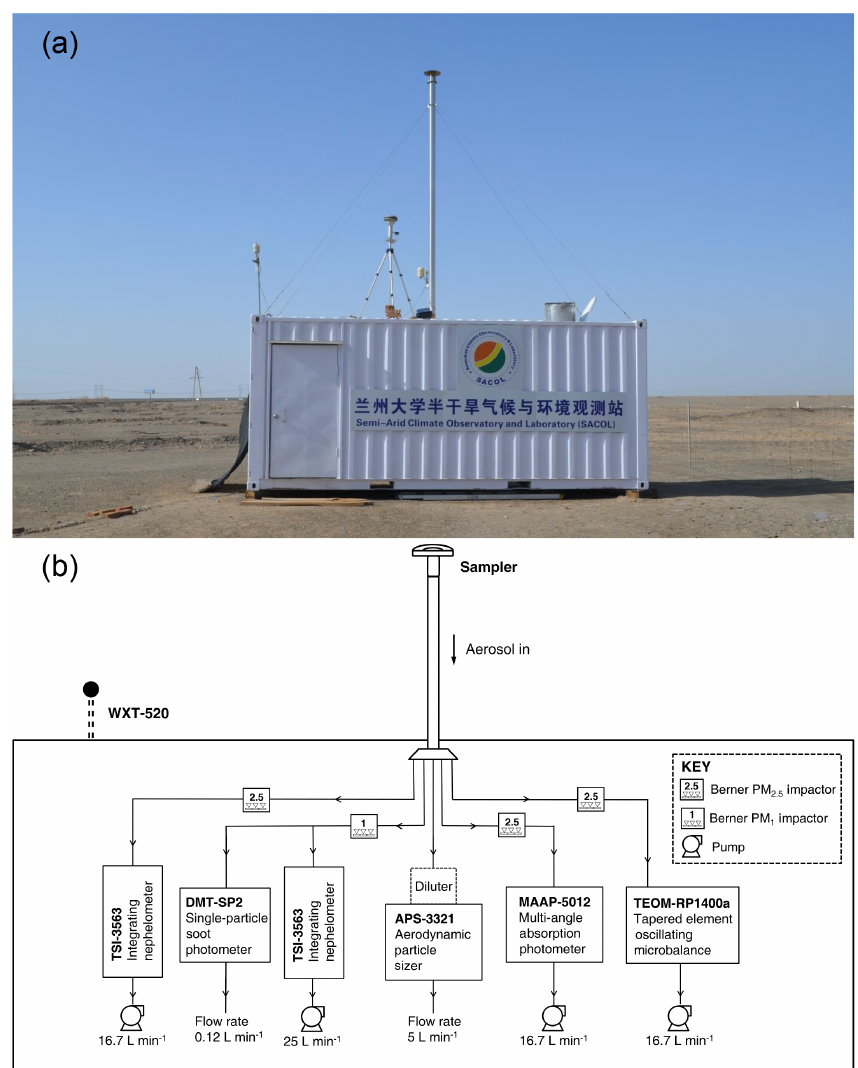
Figure 3. (a) The ground-based mobile laboratory in Dunhuang and (b) the schematic diagram of the ensemble instrumentation system.